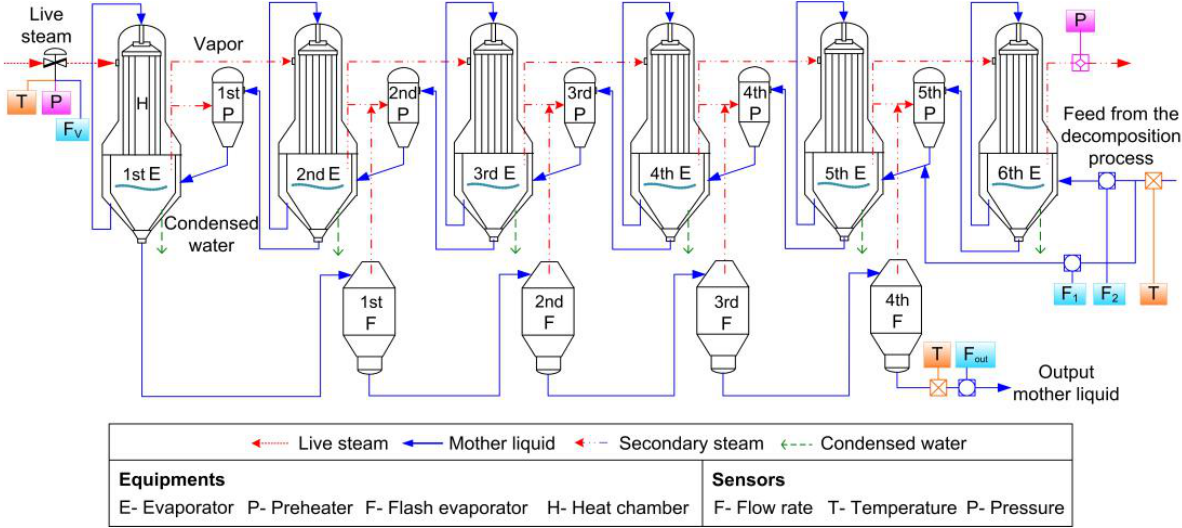
Figure 1. The sodium aluminate solution evaporation process in alumina production.